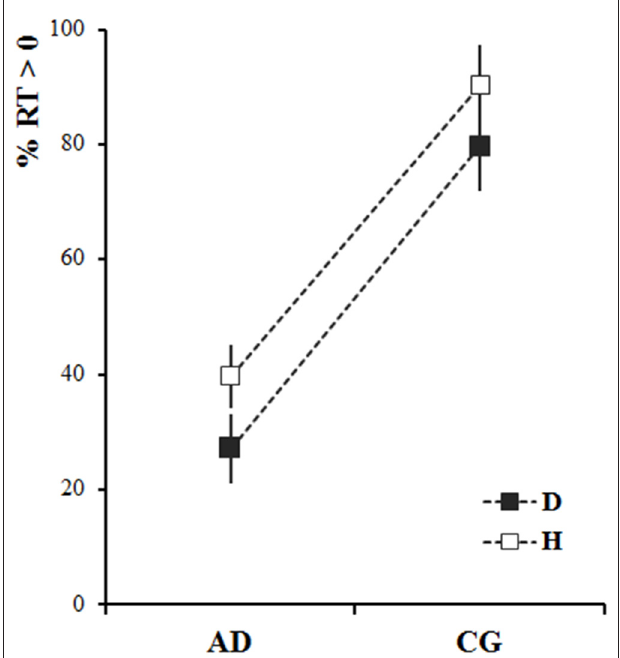
FIGURE 2 | Percentage of non-anticipated responses (reaction time, RT > 0) for Alzheimer’s disease patients (AD) and healthy elderly participants (control group, CG), after observing the dot (D-black) and the human demonstrator (H-white). The squares represent the average values calculated across the participants and stimuli velocities. The vertical bars represent the standard